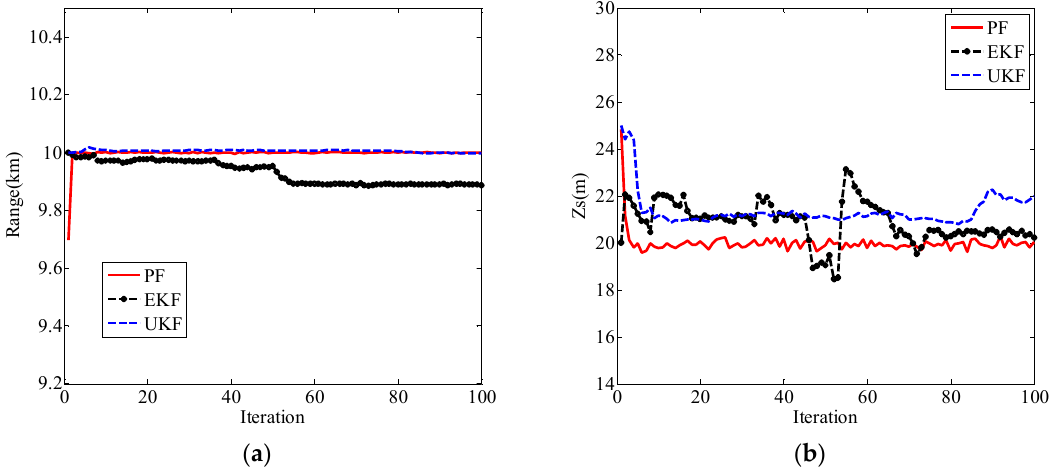
Figure 5. Localization results for PF, extended Kalman filter (EKF), and unscented Kalman filter (UKF). ( a ) Range estimation results for PF, EKF, and UKF; ( b ) source depth estimation results for PF, EKF, and UKF.